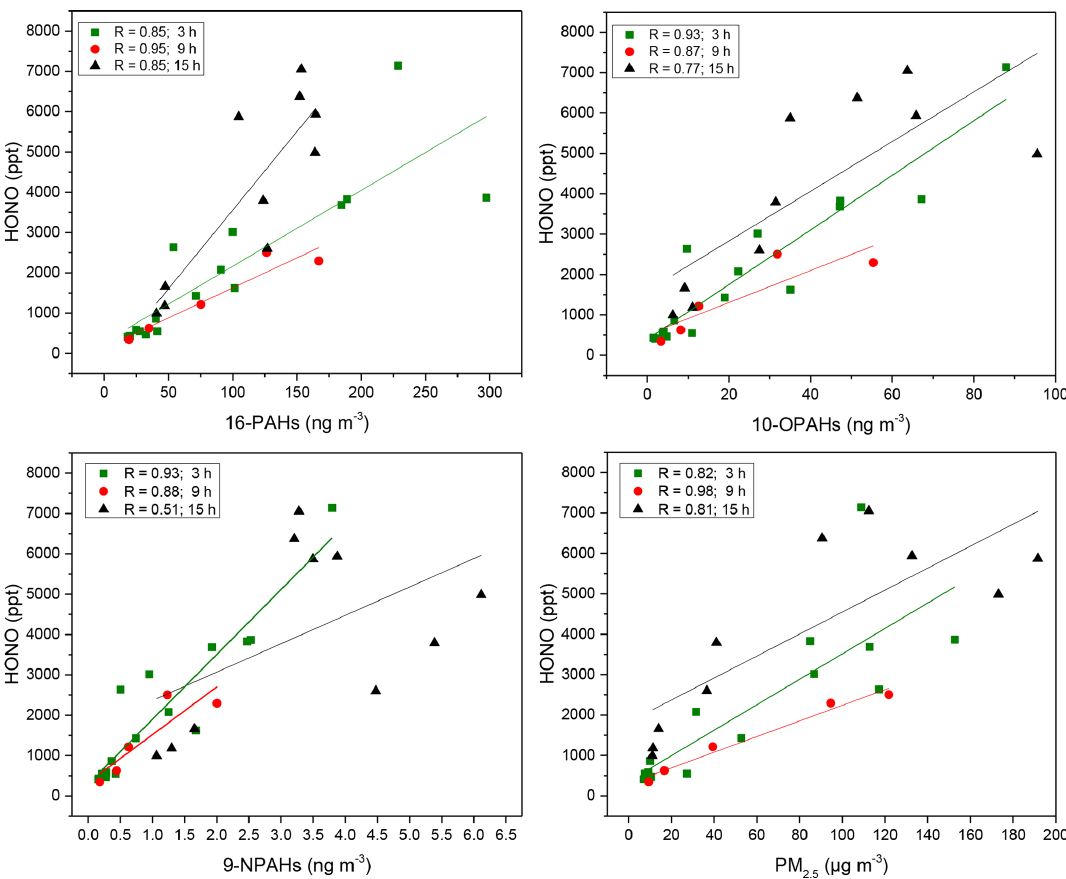
Figure 5. Correlation coefficients of P PAHs, P OPAHs, P NPAHs and PM 2 . 5 with HONO. The time sampling resolution of 3 and 9h refers to daytime concentrations and 15h to nocturnal concentrations. Significance levels were between 0.001 and 0.05 except for HONO and NPAHs at night for which the P level > 0 . 05, and the Pearson coefficient was